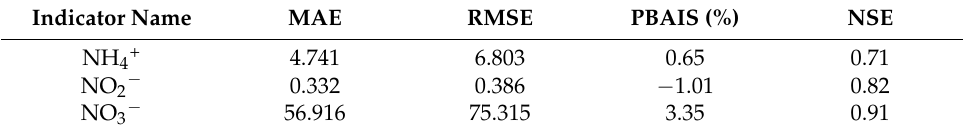
Figure 3. Model validation: simulated versus monitored values for ( a ) NH 4+ ; ( b ) NO 2 − ; and ( c ) NO 3 − .